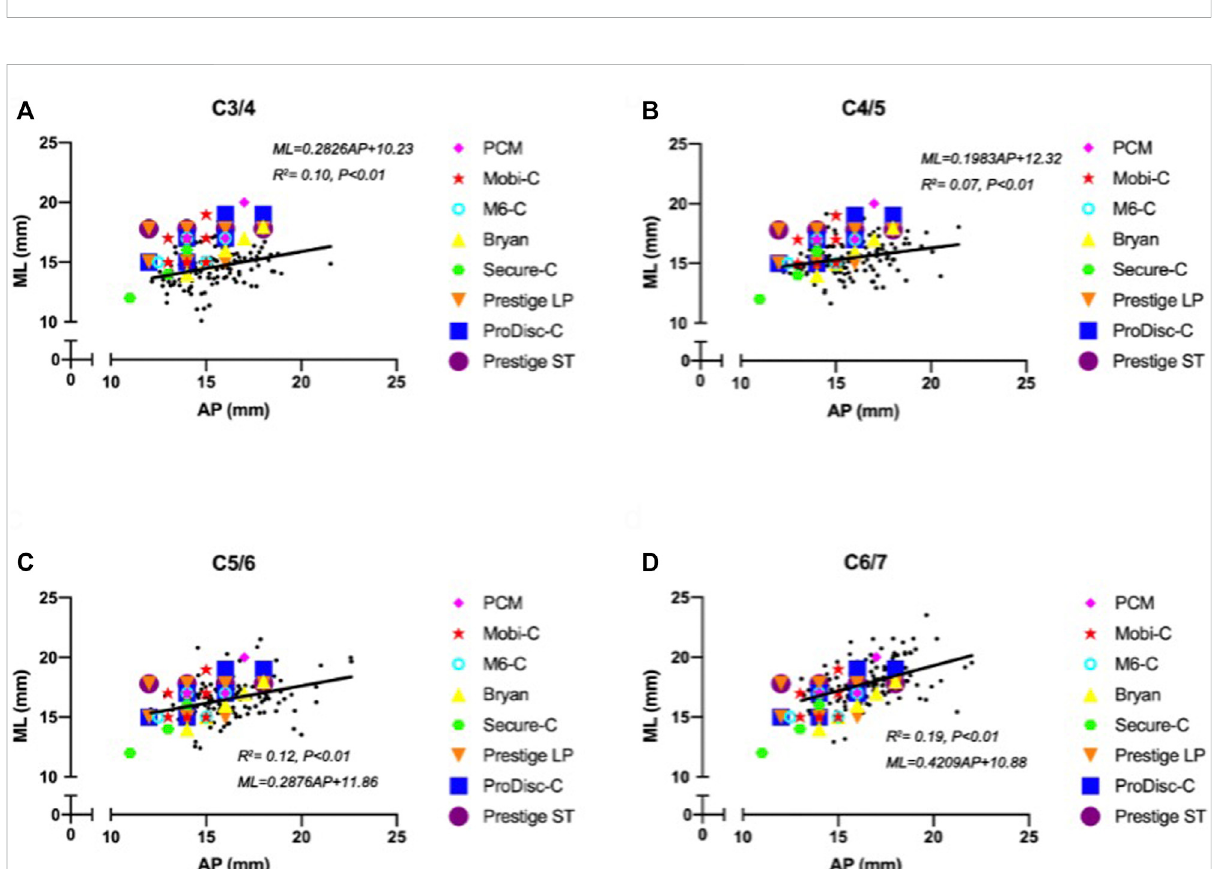
FIGURE 4 Mismatch between cervical anatomical data and the sizes of prostheses.